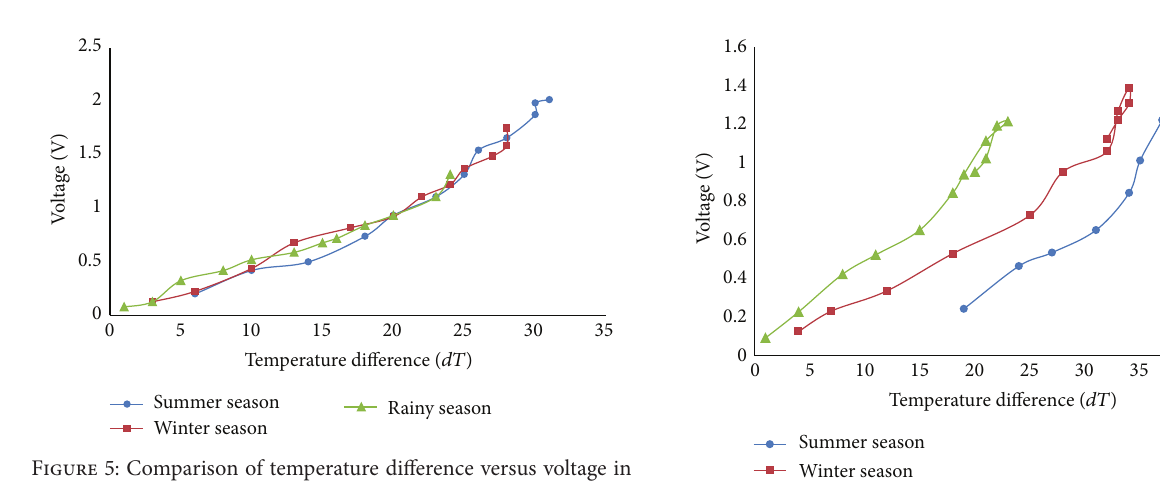
Figure 5: Comparison of temperature difference versus voltage in the duration of 8.00–10.00 am by using thermoelectric generator.